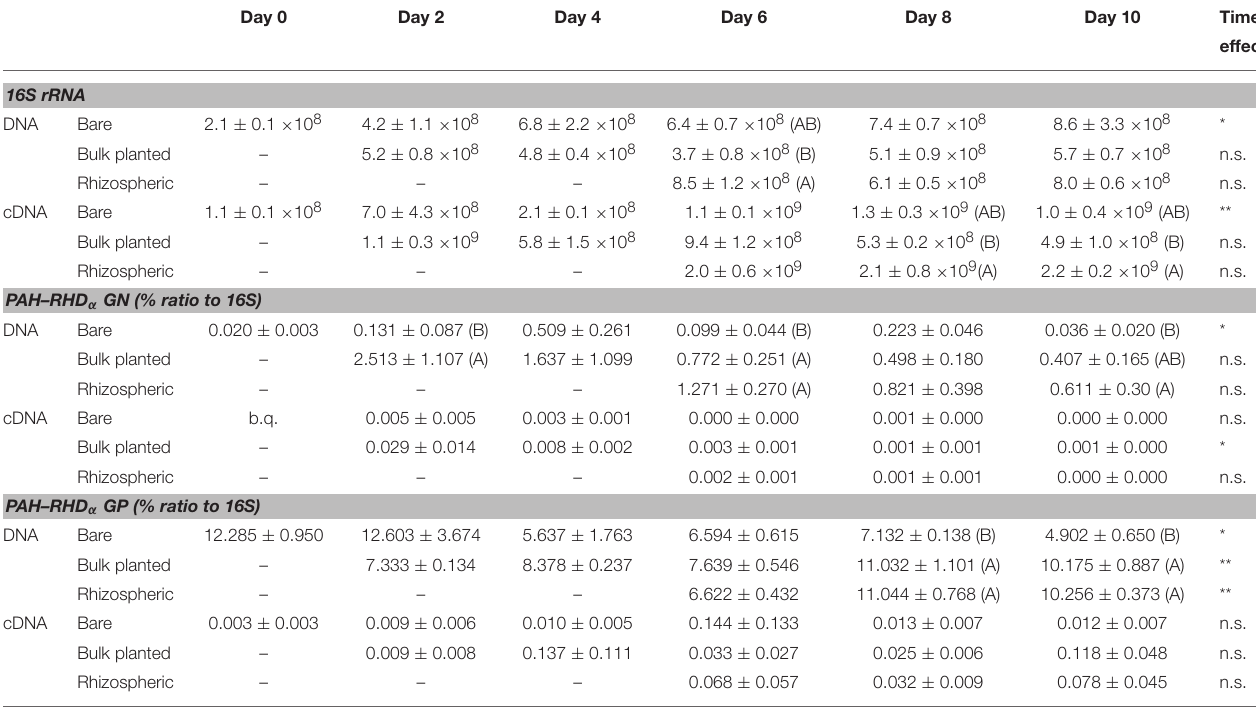
TABLE 1 | Quantification of bacterial 16S rRNA and PAH–RHD α genes and transcripts in soils from 0 to 10